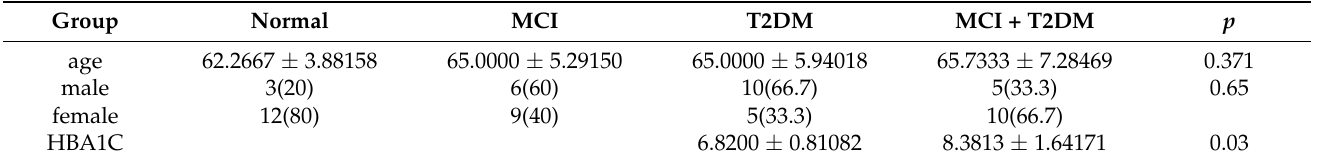
Table 2. Patient baseline